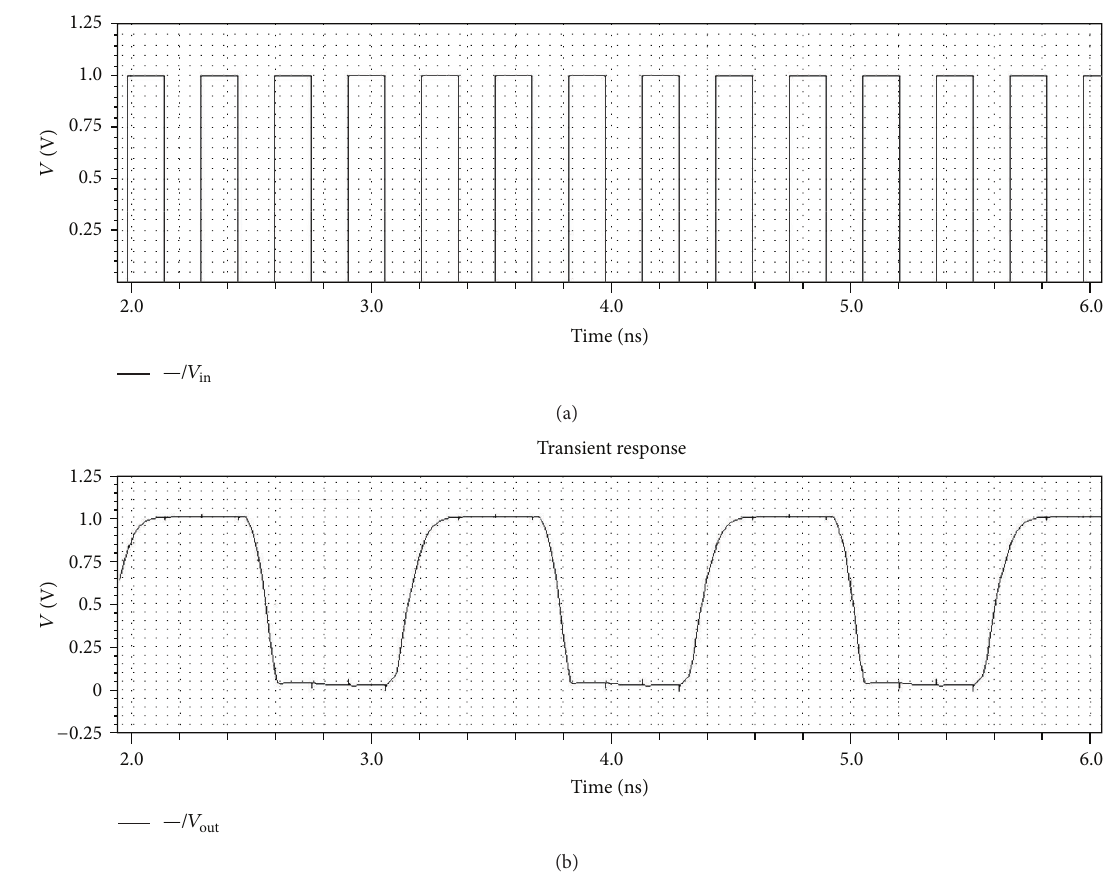
Figure 7: Square wave input at 3.268 GHz and resulting output. Table 5: Measured operating parameters of proposed circuits with skew reduction